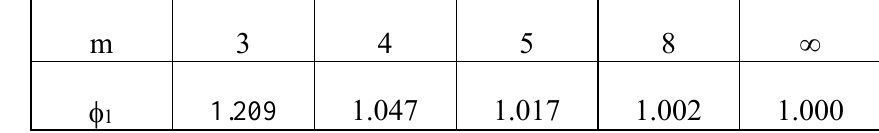
Effect of the side number of the polygon section m in buckling factor.